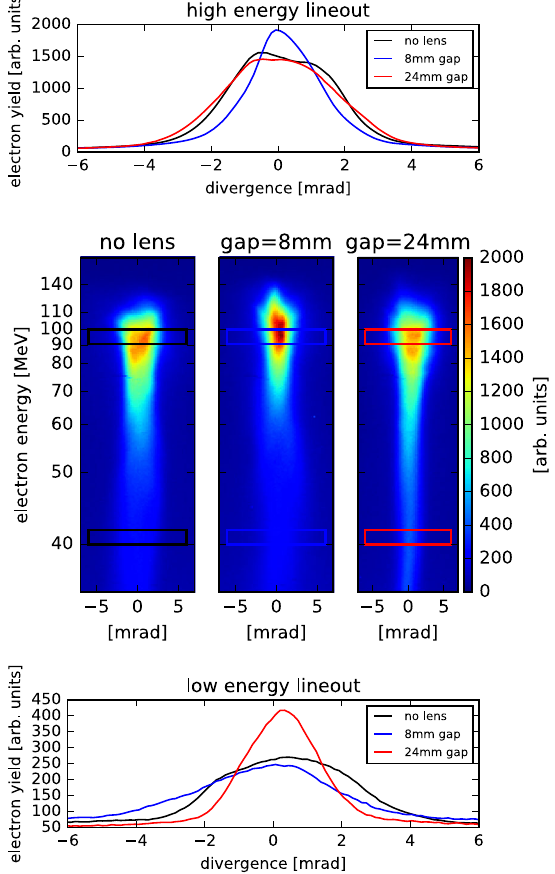
FIG. 6. Spectral dependence of the plasma lens: Each of the three spectra is aligned and averaged over 40 – 50 shots. The spectra show a comparison between the divergence of the electrons without (left) and with plasma lens (middle and right). The plasma lens uses an electron density of ð 1 . 2 (cid:3) 0 . 8 Þ × 10 19 cm − 3 . Profiles of the high energy part (90 – 100 MeV) and the low energy part (40 – 42 MeV) are shown on top and bottom. It is shown that the high energy electrons are focused at 8 mm gap length (blue), whereas the low energetic electrons are focused at 24 mm gap length (red).